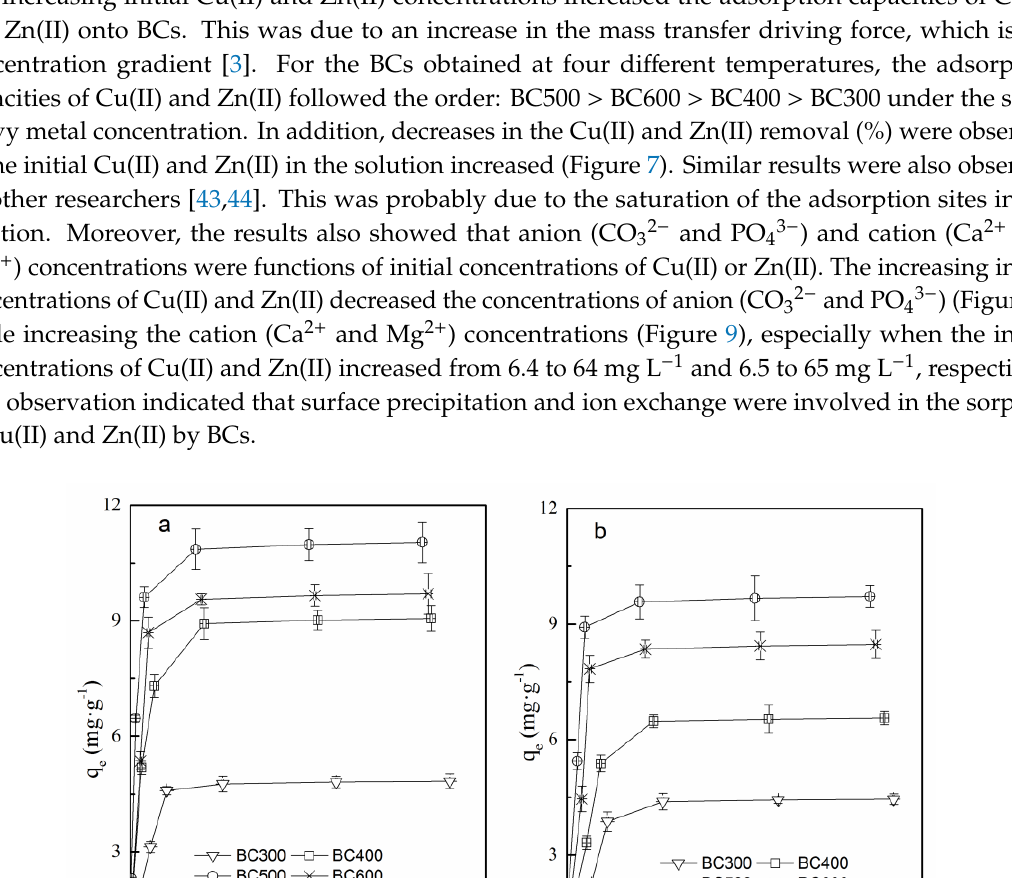
Figure 7. Effect of initial heavy metal concentration on the percent removal of the Cu(II) ( a ) and Zn(II) ( b ) (reaction temperature 25 °C; BC dosage 5 g·L −1 ; initial solution pH 5.0; contact time 1440 min). Error bars represent standard error ( n = 3). LSD is the least significant difference at p < 0.05 under the same initial heavy metal concentration.